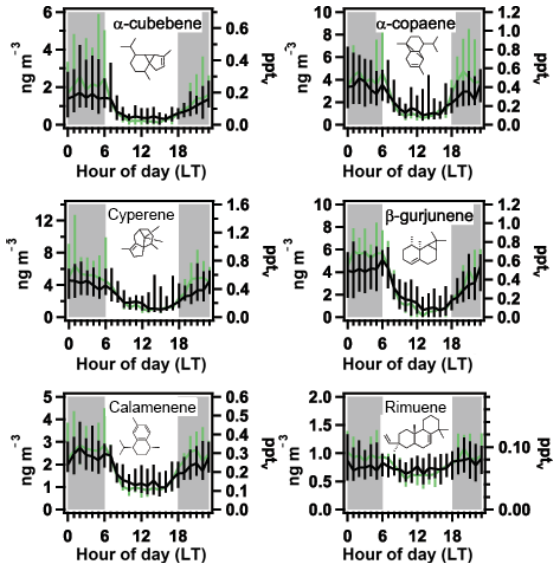
Figure 6. Average diel profiles of selected sesquiterpenes and one diterpene (rimuene) for the wet season (light green) and dry season (black) in gas phase. A solid line is drawn through median values, and bars indicate a range from 25th to 75th percentiles. Local night- time hours are indicated in grey shading.